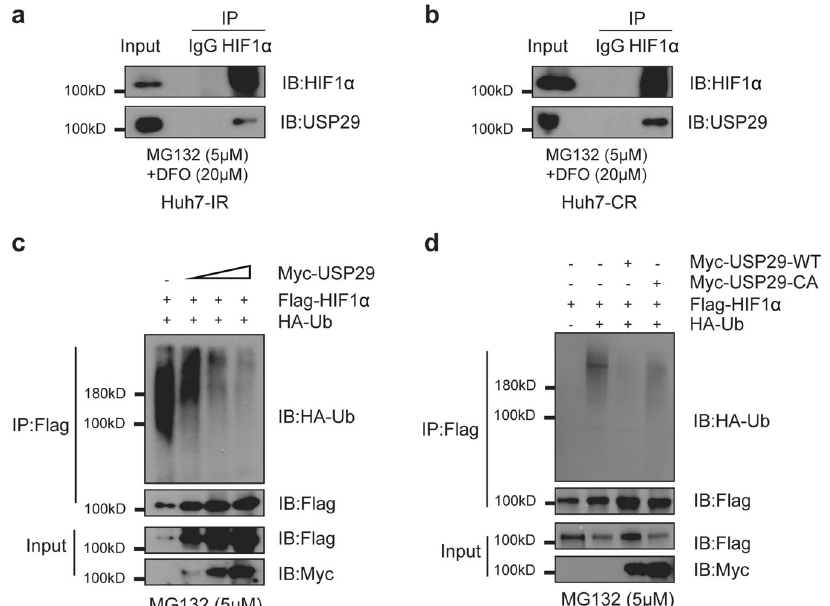
Fig. 3 USP29 interacts with and deubiquitylates HIF1 α . a , b Endogenous HIF1 α interacts with USP29 in Sorafenib-resistant Huh7-IR and Huh-CR cells. Huh7-IR ( a ) and Huh-CR ( b ) cells were treated with 5 µM MG132 and 20 µM DFO for 8 h before harvest to enrich for HIF1 α protein. anti-HIF1 α antibody and irrelevant anti-IgG as control were used to precipitate (IP) endogenous HIF1 α . Immunoprecipitates were then immunoblotted (IB) for HIF1 α and for USP29. Input represents 1/10 of the lysate used for the immunoprecipitations. Results represent three independent experiments. c USP29 removes poly-ubiquitin from HIF1 α . Increasing amounts of a plasmid encoding for Myc-USP29 were transfected together with Flag-HIF1 α and HA-tagged ubiquitin (HA-Ub) into HEK-293T cells. Flag-HIF1 α was then immunoprecipitated (IP) with anti-Flag antibody, and the precipitates were immunoblotted (IB) for HA (HA-Ub) and for Flag (Flag-HIF1 α ). USP29 reduced the poly- ubiquitination level of HIF1 α . Input represents 1/10 of the lysate used for the immunoprecipitations. 5 µM MG132 was added into the culture medium 8 h before harvest to prevent proteasomal degradation. Results represent three independent experiments. d The catalytic activity of USP29 is required to remove poly-ubiquitin from HIF1 α and to stabilize it. Plasmids encoding for Myc-tagged wildtype USP29 or Myc-tagged CA-mutant USP29 were transfected together with Flag-HIF1 α and HA-tagged ubiquitin (HA-Ub) into HEK-293T cells. HIF1 α was then immunoprecipitated (IP) with anti-Flag antibody, and the precipitates were immunoblotted (IB) for HA (HA-Ub) and for Flag (Flag-HIF1 α ). USP29 reduced the poly-ubiquitination level of HIF1 α . Input represents 1/10 of the lysate used for the immunoprecipitations. 5 µM MG132 was added into the culture medium 8 h before harvest to prevent proteasomal degradation. Results represent three independent